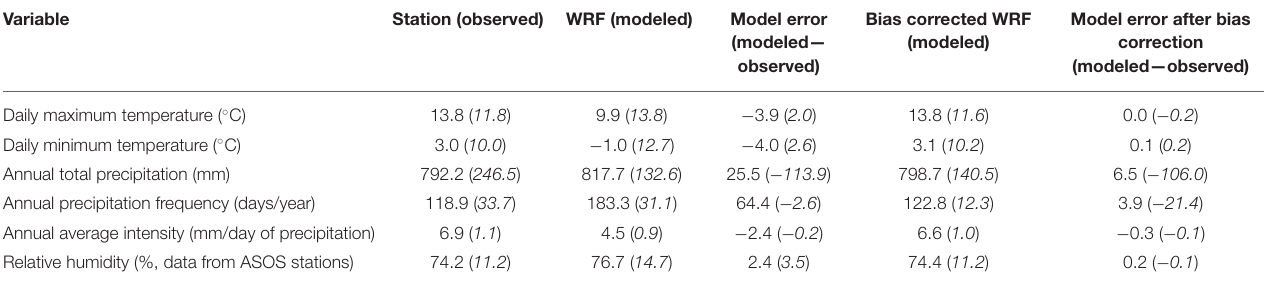
TABLE 1 | Average ( standard deviation ) of station and WRF variables of interest for hydrologic inputs at the five observational stations within the watershed for 1991–2005.